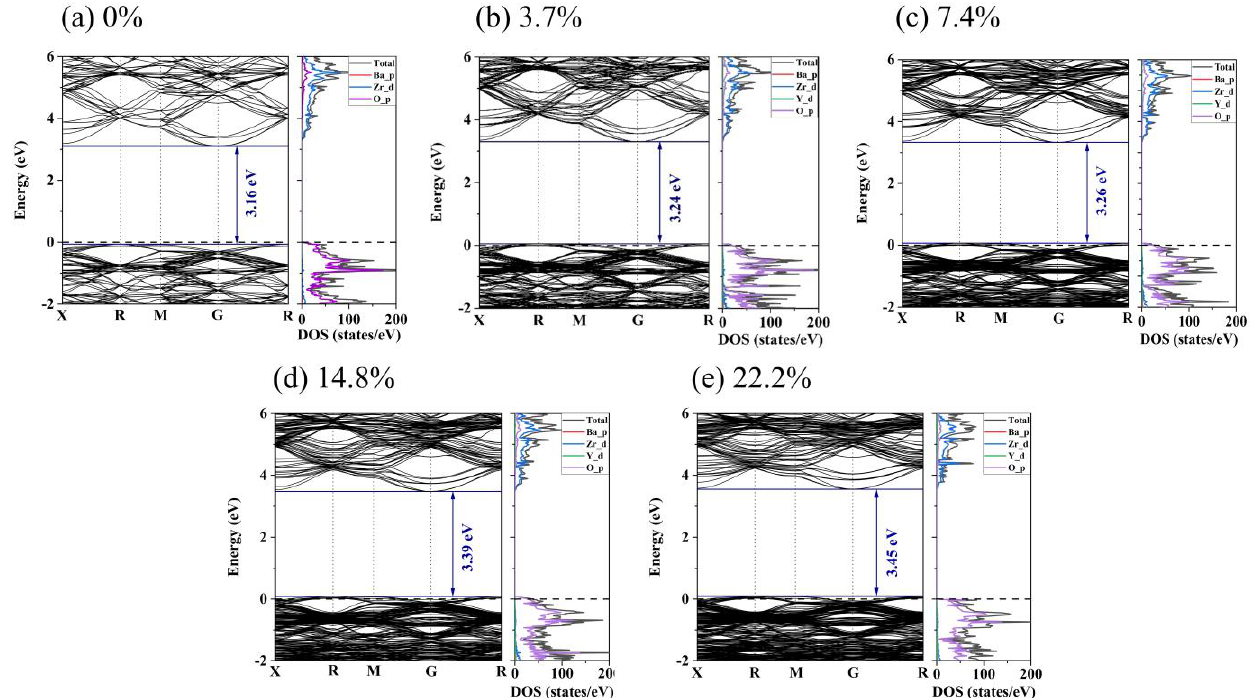
Figure 9. Electronic band structure and density of states for BZYs.